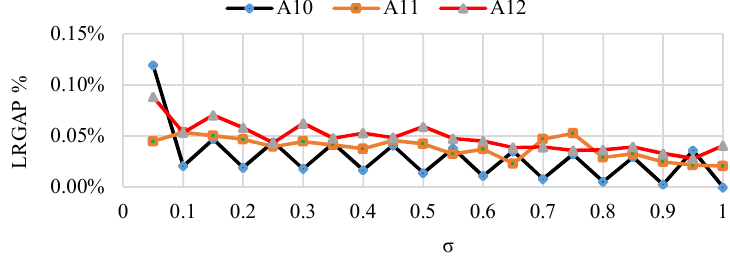
Fig. 8 . Sensitivity analysis of the LRGAP % to σ for large-sized